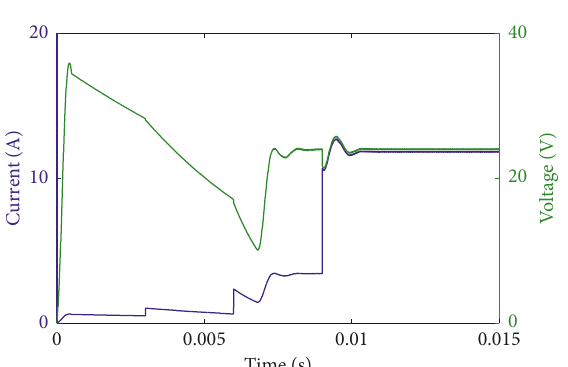
Figure 16: Plot for load current and voltage for varying load using the IMC-based controller.